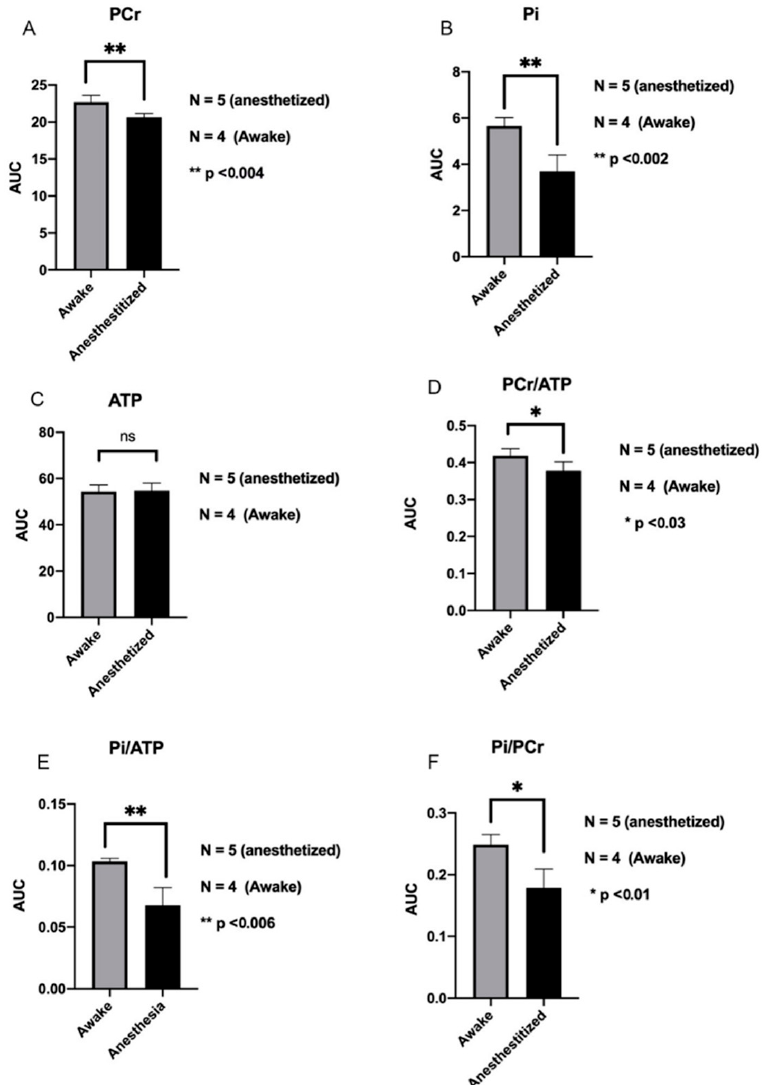
Figure 6. Bioenergetic status of the brains of awake and anesthetized mice. Levels of PCr and Pi decreased in anesthetized mice relative to awake mice ( A , B ). ATP levels in the brain were maintained ( C ). PCr/ATP levels in awake mice are increased relative to anesthetized mice ( D ). Increases Pi/ATP levels in awake mice relative to anesthetized mice ( E ). Increased levels of Pi/PCr in awake mice ( F ). N = 5 anesthetized and N = 5 awake mice.